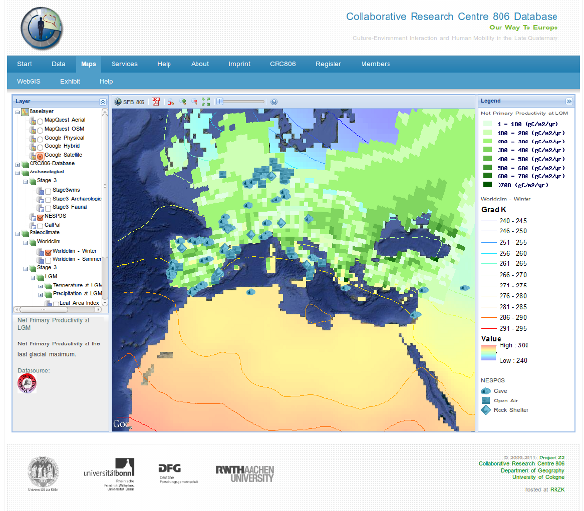
Figure 5: Screenshot of the WebGIS interface, showing a Google Maps Aerial baselayer overlayed with the mean LGM winter tem- peratures from PMIP II, and overlayed with the LGM net primary productivity from Stage3 and the NESPOS